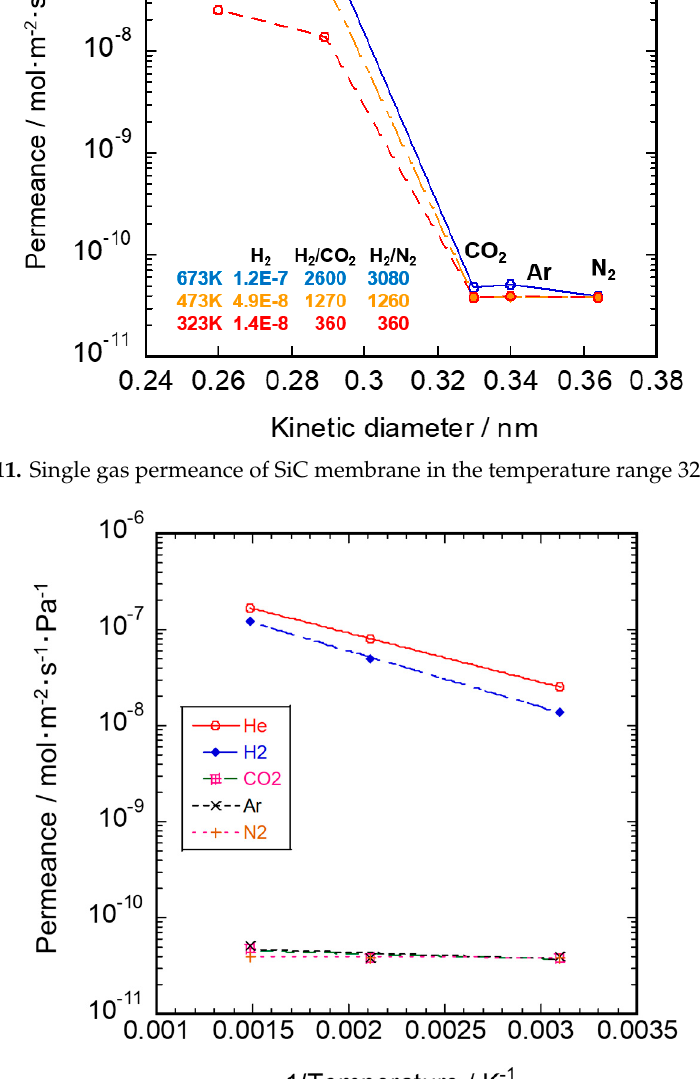
Figure 12. Temperature dependence of single gas permeance for SiC membrane.